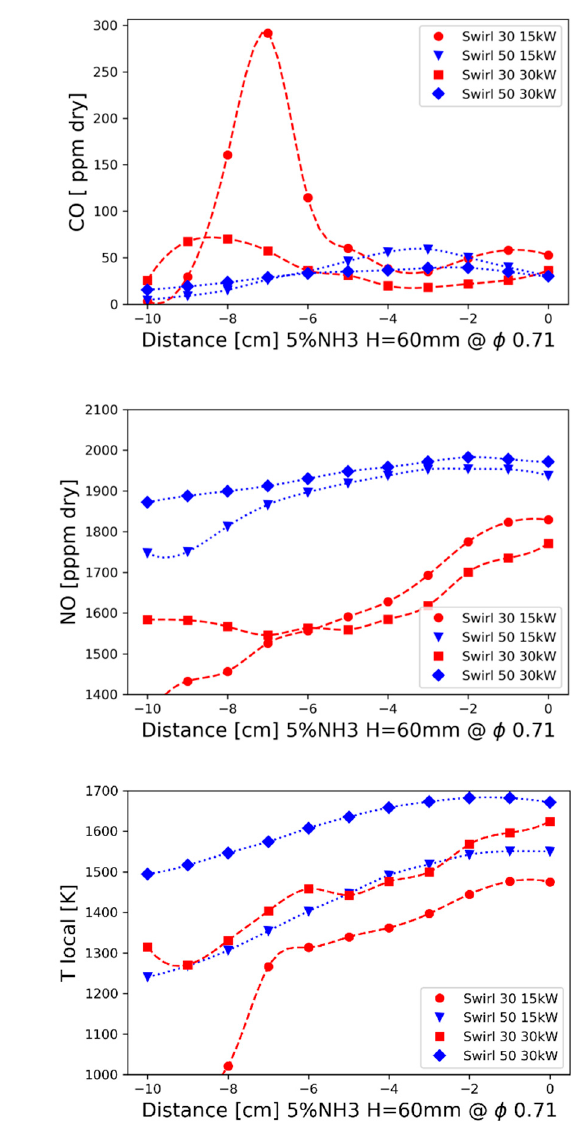
Figure 5. Comparison of the local species concentration for different swirlers and firing rates—axial position 30 mm and 60 mm, ϕ = 0.71.